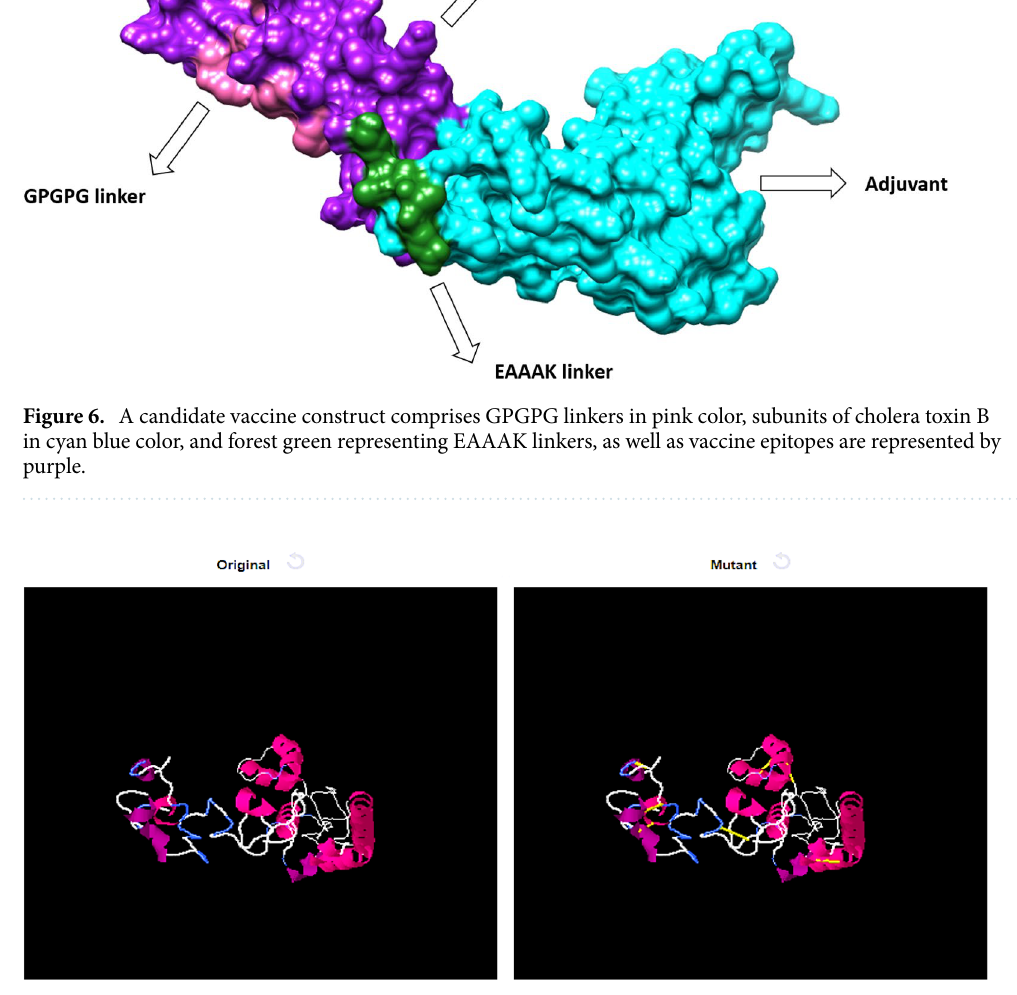
Figure 7. Structures of vaccines that have been mutated. Mutant structures have yellow bands which indicate the introduction of disulfide